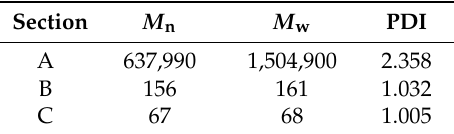
Figure 3. Molecular weights of the prepolymer as determined using gas permeation chromatography (GPC): ( a ) the polymer-forming section, ( b ) the section corresponding to 2-EHA/IBA, and ( c ) the section corresponding to N-vinyl caprolactam (NVC). Table 1. Molecular weight distribution of the